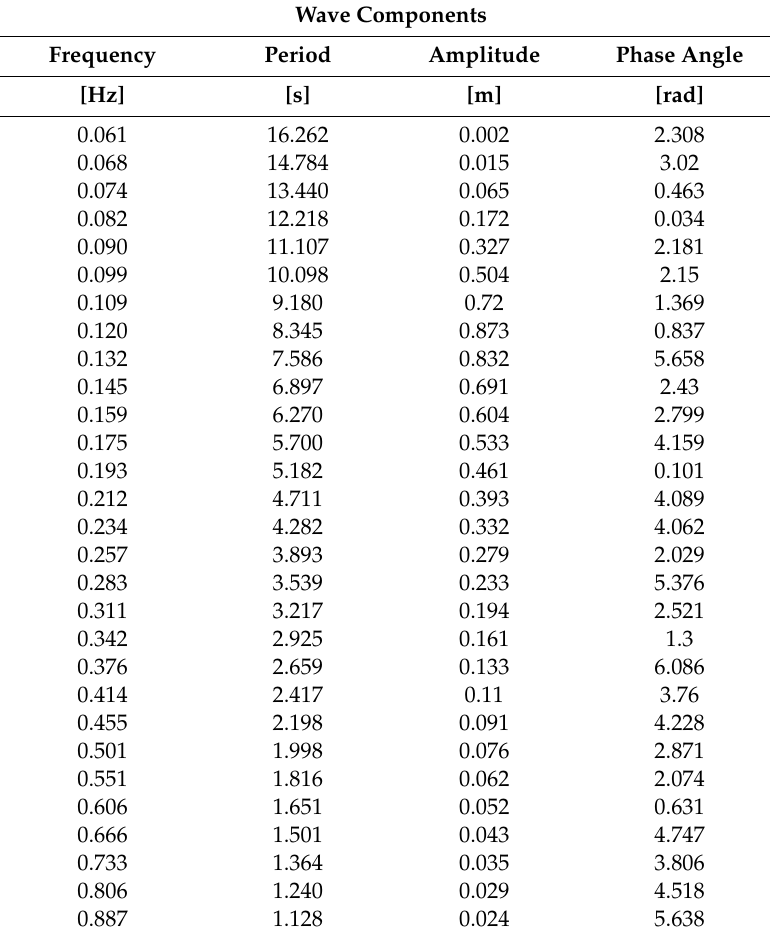
Table A1. Irregular wave